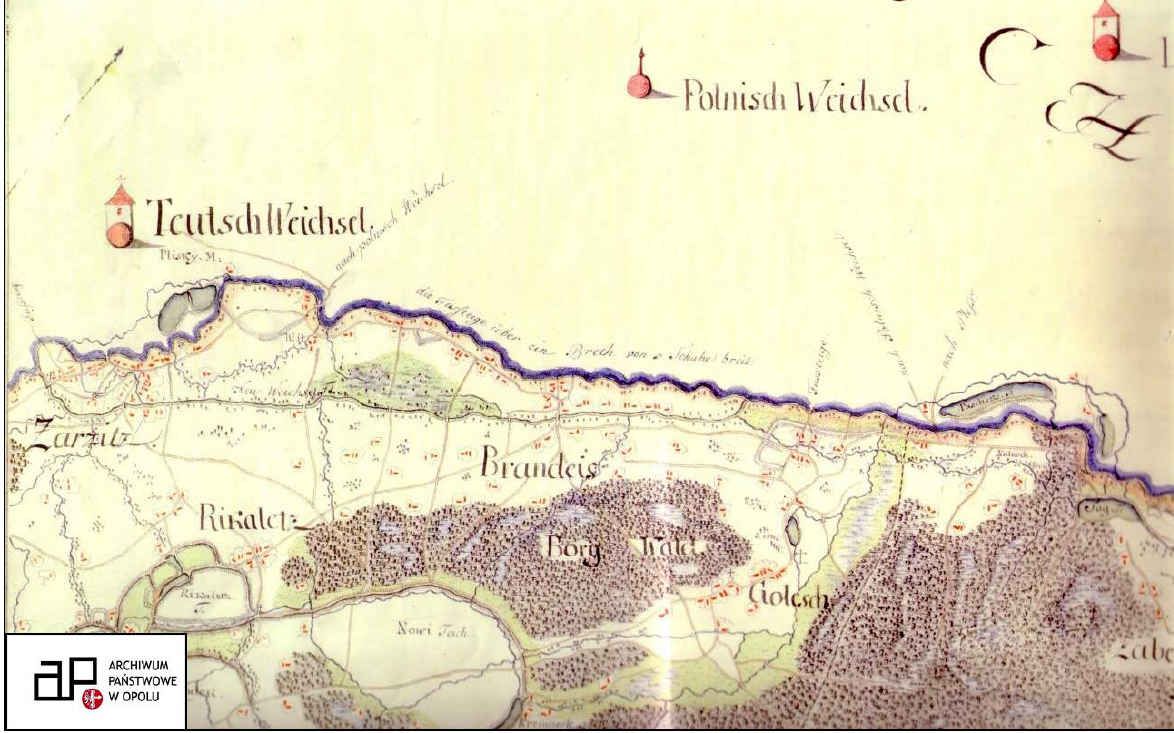
Fig. 5. Changes to the Little Vistula channel after the July flood of 1736 (after General-Mappa…, 1763–1764, 1780 Kriegsarchiv,